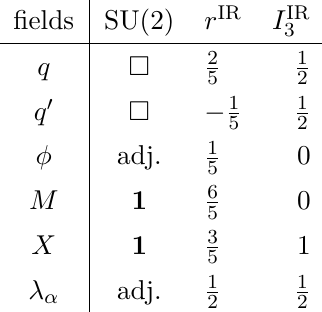
Table 1 . The charges of primaries of all N = 1 (chiral) UV fields. The first column of charges give the representation under the SU(2) gauge group. Here I IR refers to the N = 2 superconformal 3 SU(2) weight in the IR (i.e., I IR → R ), and r IR refers to the N = 2 superconformal U(1) r charge R 3 in the IR (i.e., r IR → r ), which is determined through a -maximization. These quantum numbers are visible in the UV description (hence the power of this RG flow), and the superpotential has quantum numbers r IR ( W ) = I IR ( W ) = 1 3